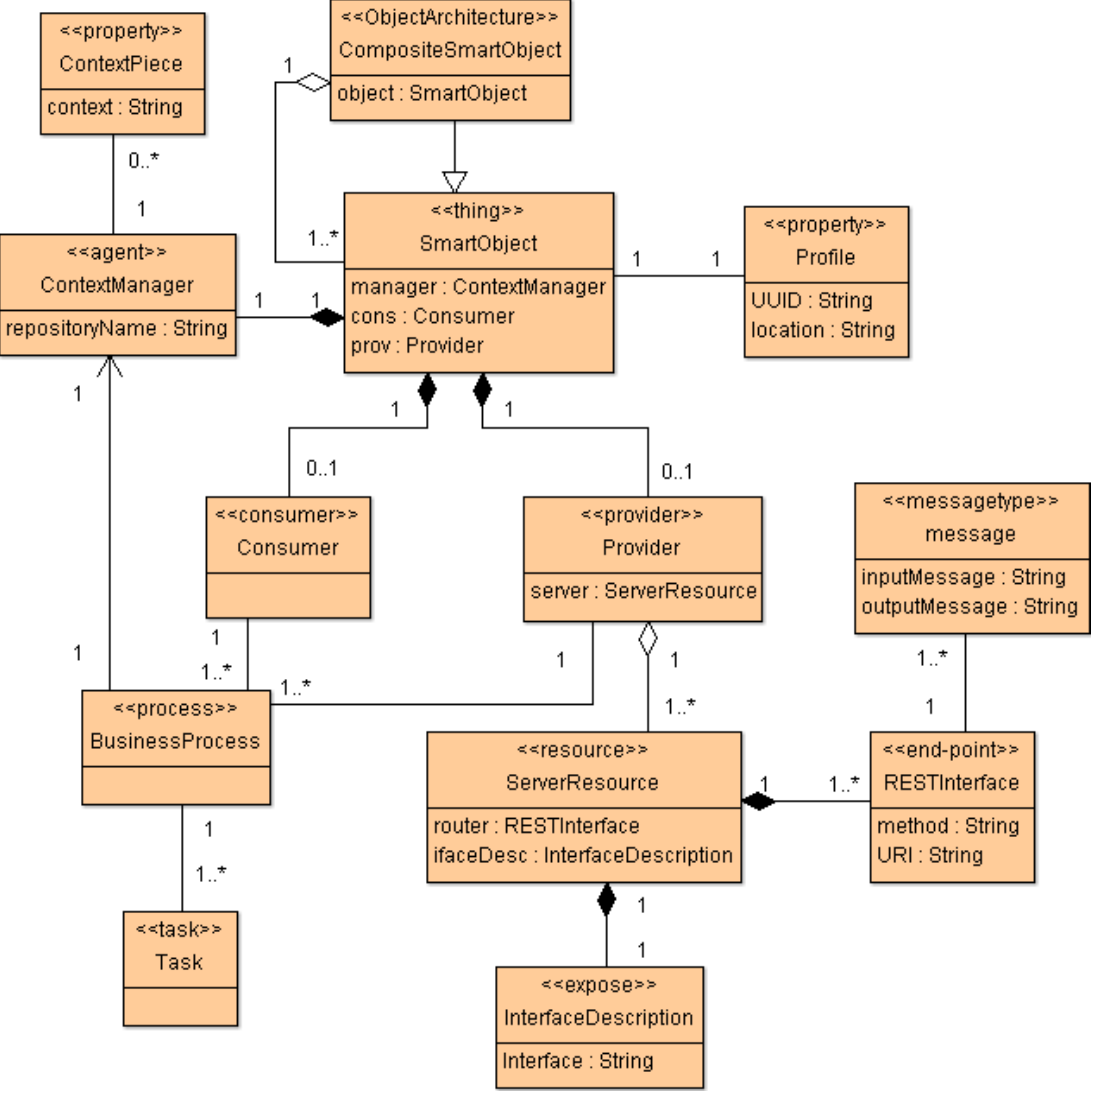
Figure 5. SOM’s viewpoint of the SsML